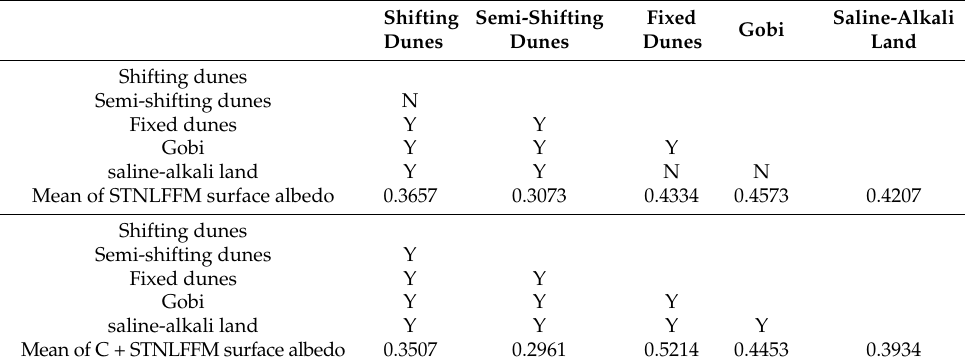
Table 5. Risk detector of surface albedo over different underlying